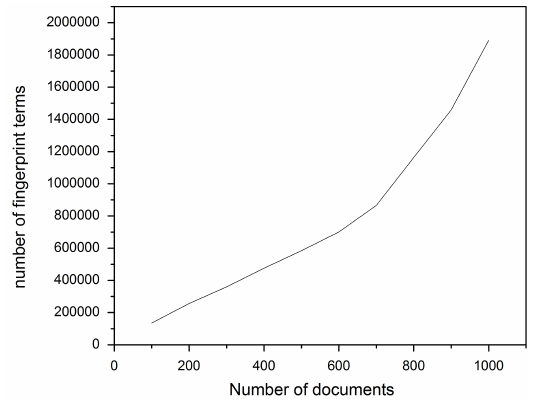
Figure 6. Effect of collection size on fingerprint